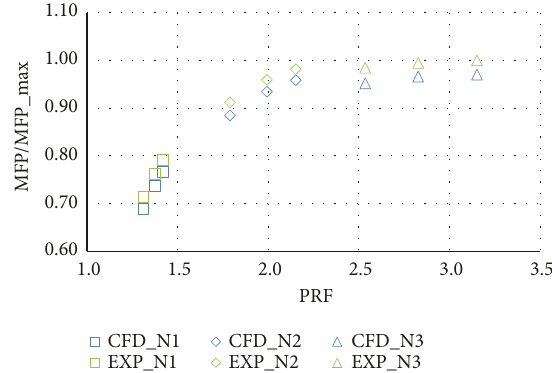
Figure 5: MFP (referred to maximum value) vs PRF in full admission, CFD (blue) and experimental data (green).